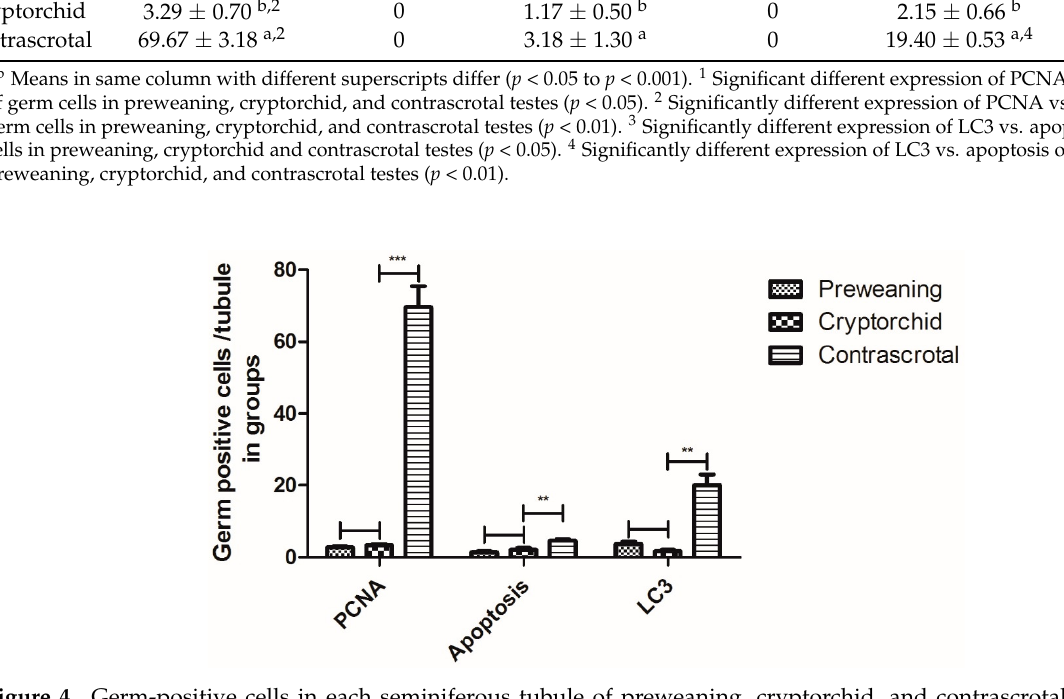
Figure 4. Germ-positive cells in each seminiferous tubule of preweaning, cryptorchid, and contrascrotal boar testes. ** p < 0.01, *** p < 0.001.